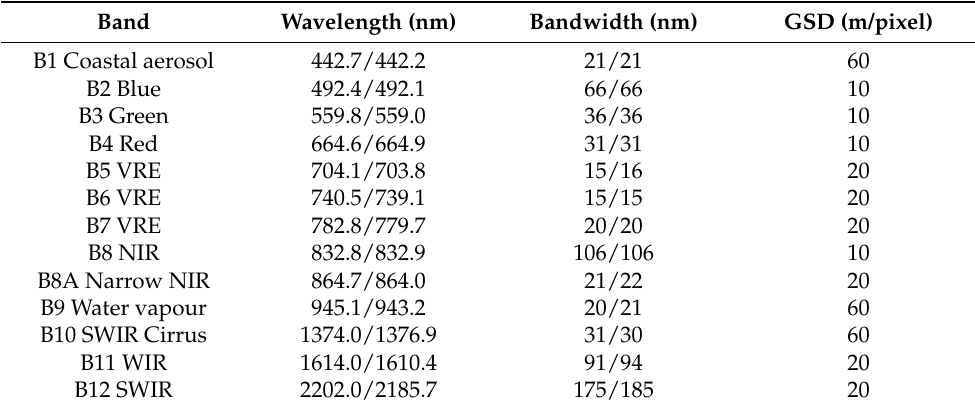
Table 3. Bands from Sentinel-2A and Sentinel-2B.